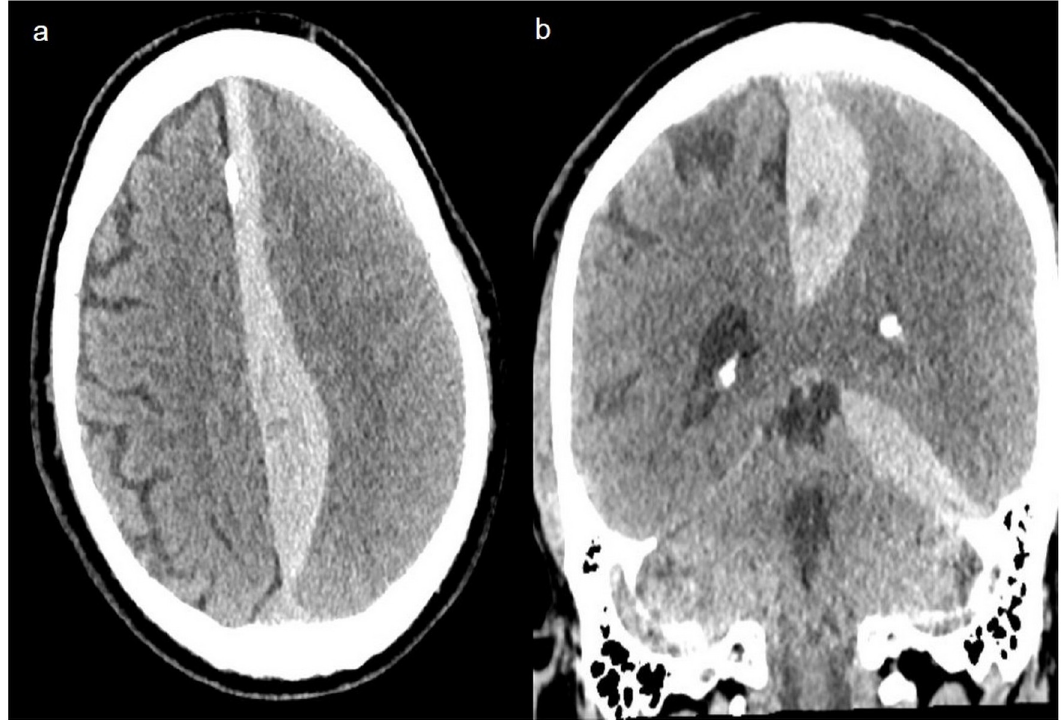
Fig 2. Case illustration. Patient 1. A 64-year-old male patient after a skiing accident with head trauma under anticoagulation (phenprocoumon and acetylsalicylic acid). He presented with an acute subdural hematoma with an interhemispheric compressive effect. The GCS at hospital arrival was 15 points, with right leg paralysis (M4/5). CT scan with a) axial and b) coronal